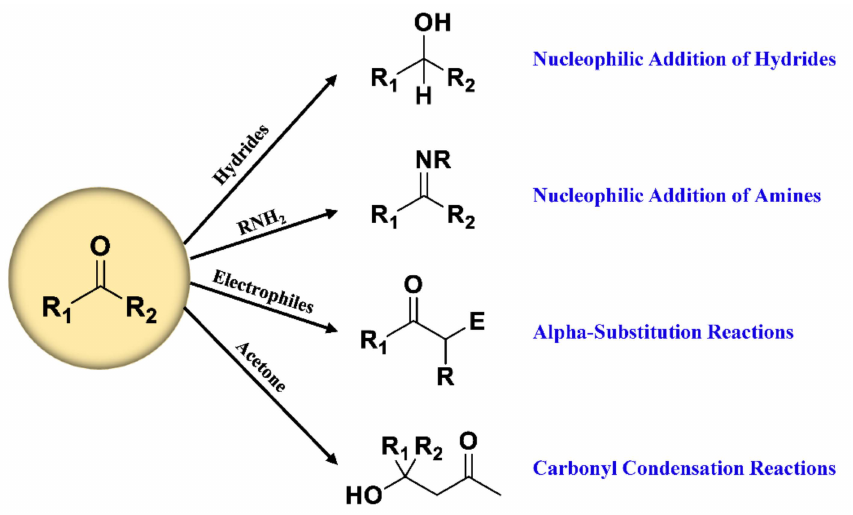
Figure 2. Classic reactions of carbonyl compounds.